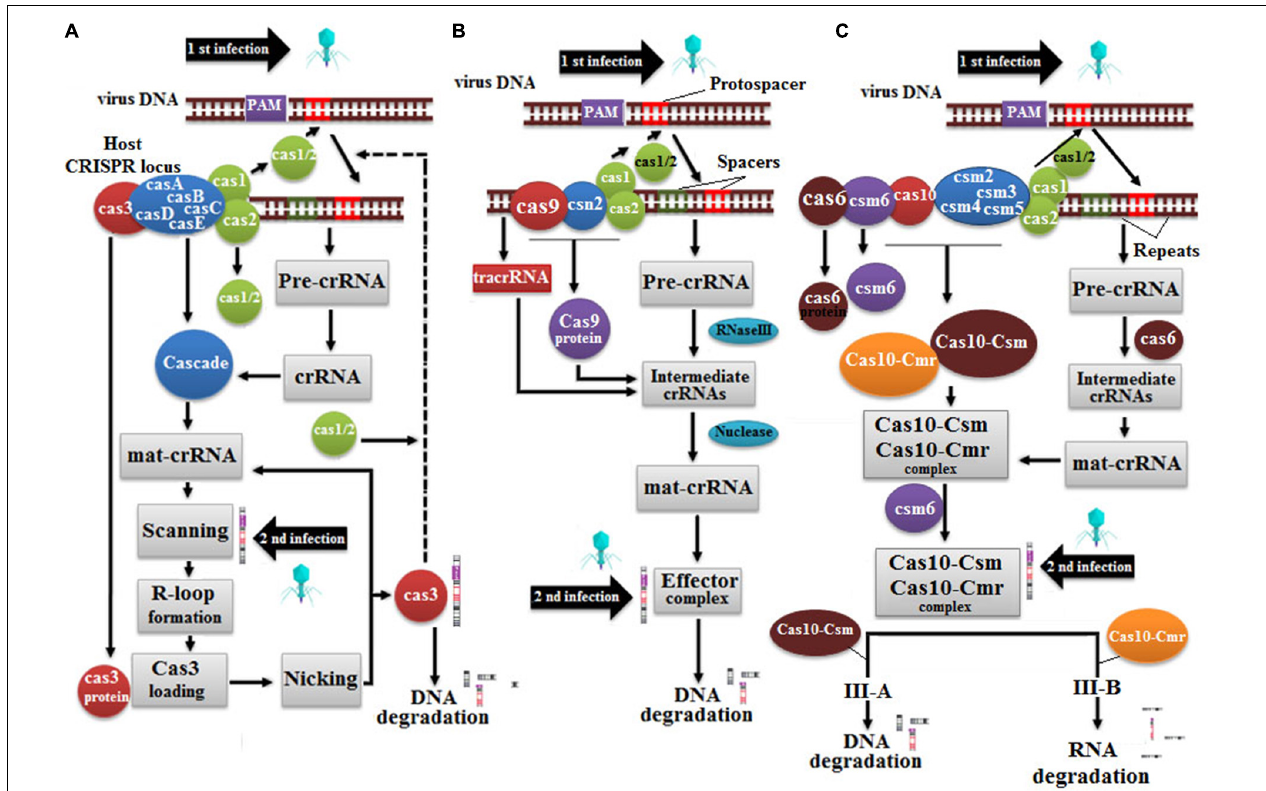
FIGURE 9 | Cas protein mechanism is as follows: (A) Type I system depends on Cas3 protein, which recognizes new viral infection and counters it, (B) Type II system depends on Cas9 proteins and tracrRNA for the biogenesis of crRNA, and (C) Type III system depends on either Cas6 or Cas10 in which Csm targets DNA while Cmr targets viral